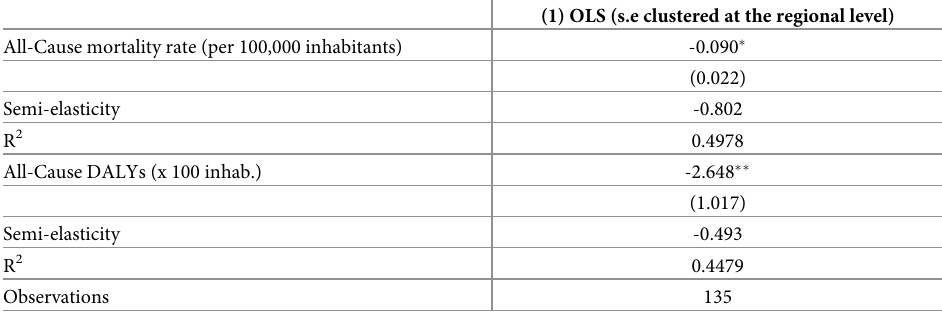
Table A2. The effect of mortality/DALYs on GDPpc growth. Long-Run Growth Regression (standard errors clus- tered at the regional level and bootstrapped using wild bootstrapping). (1) OLS (s.e clustered at the regional level)